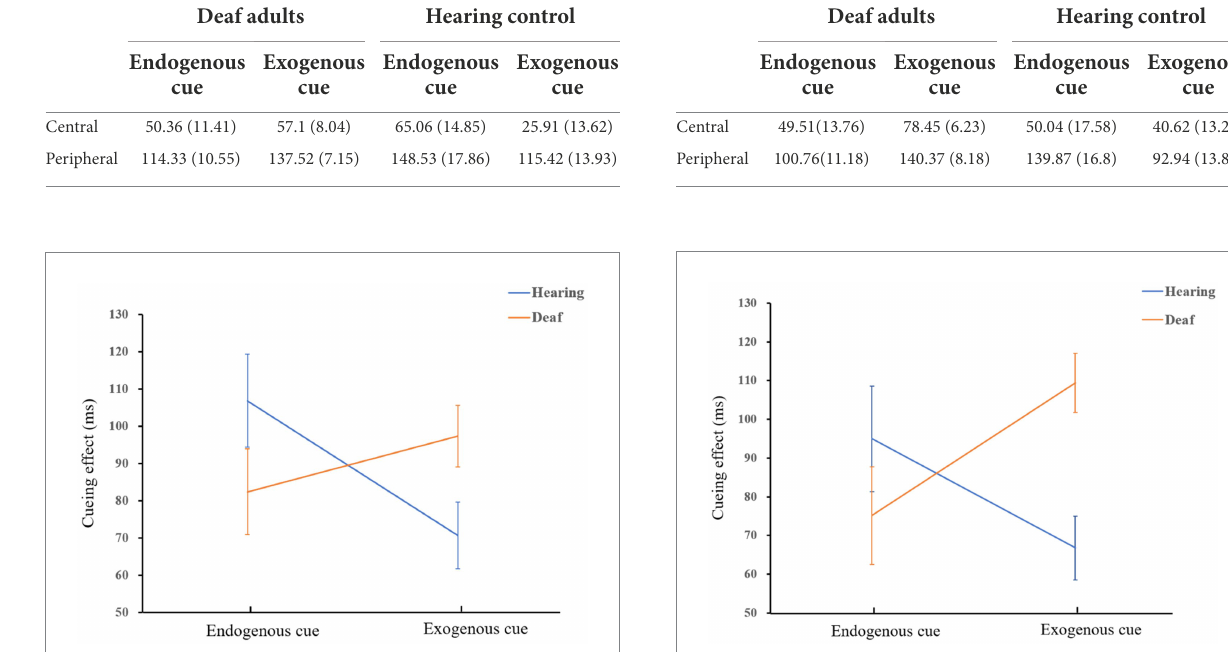
FIGURE 3 The interaction of group and cue type when there is a short ISI.